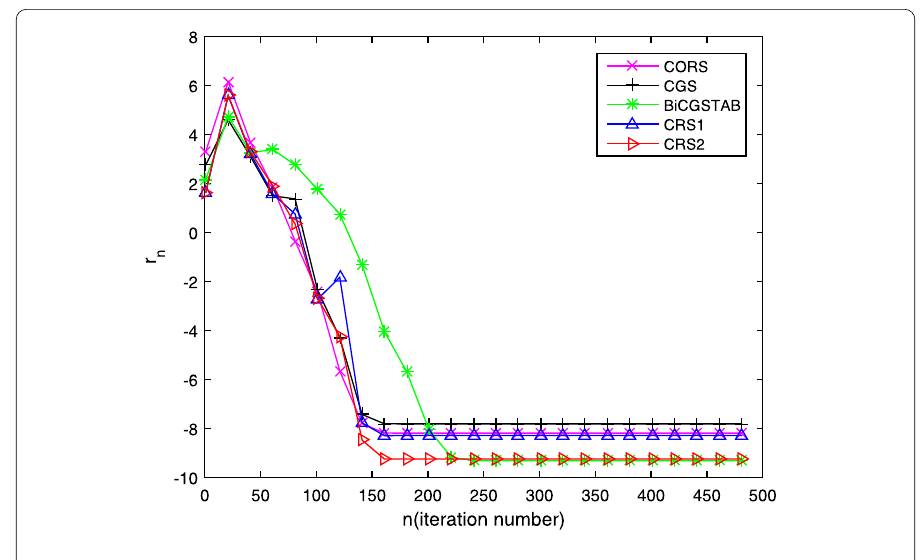
Figure 2 The residual for Example